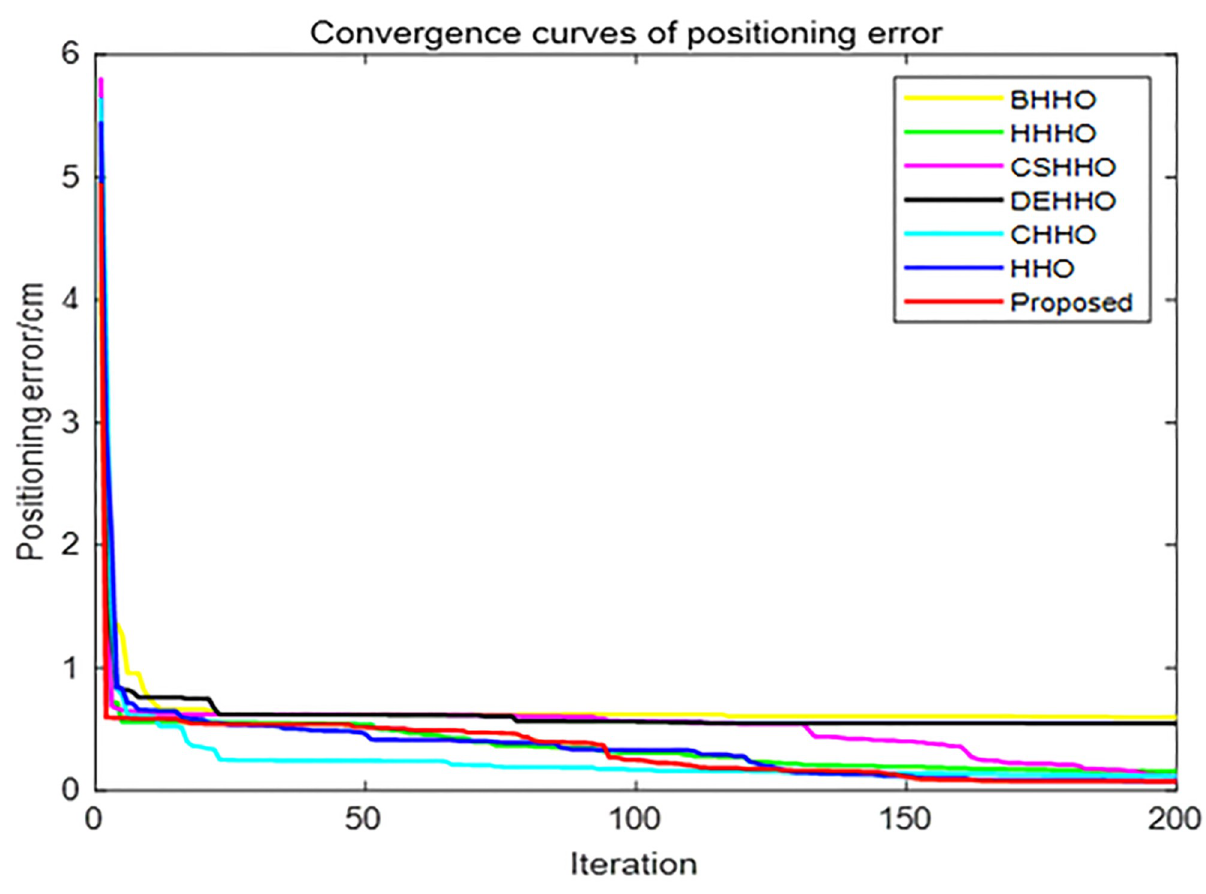
Fig 10. Convergence curves of different